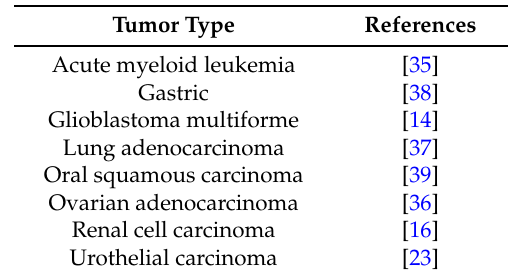
Table 2. GAS6 expression in human cancers correlates with poor prognosis, metastasis and drug